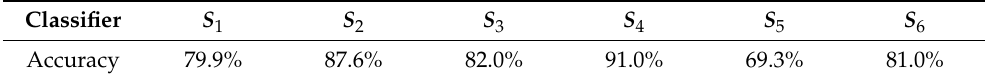
Table 3. Model accuracy (percentage of correctly classified 10-min time windows) for the six classifiers.